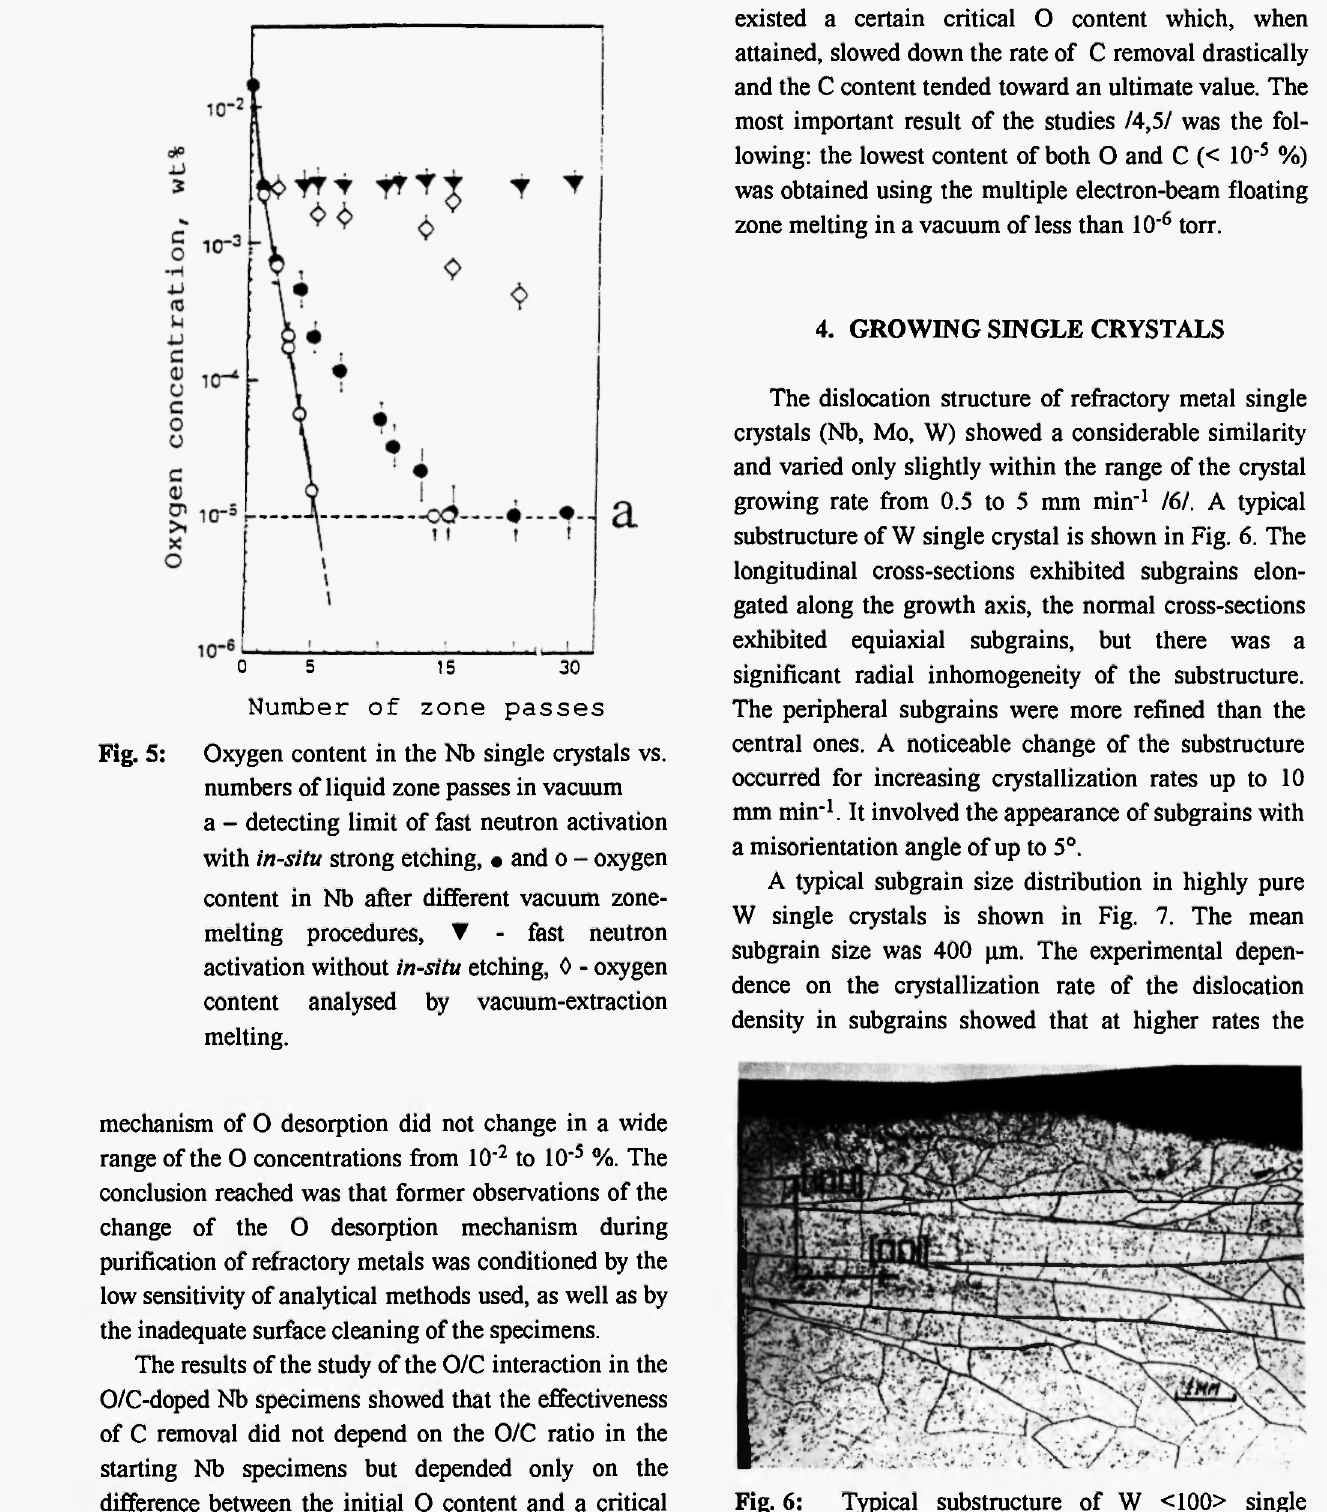
Fig. 6: Typical substructure of W <100> single crystal grown at a rate of 2 mm min" 1 (longitudinal